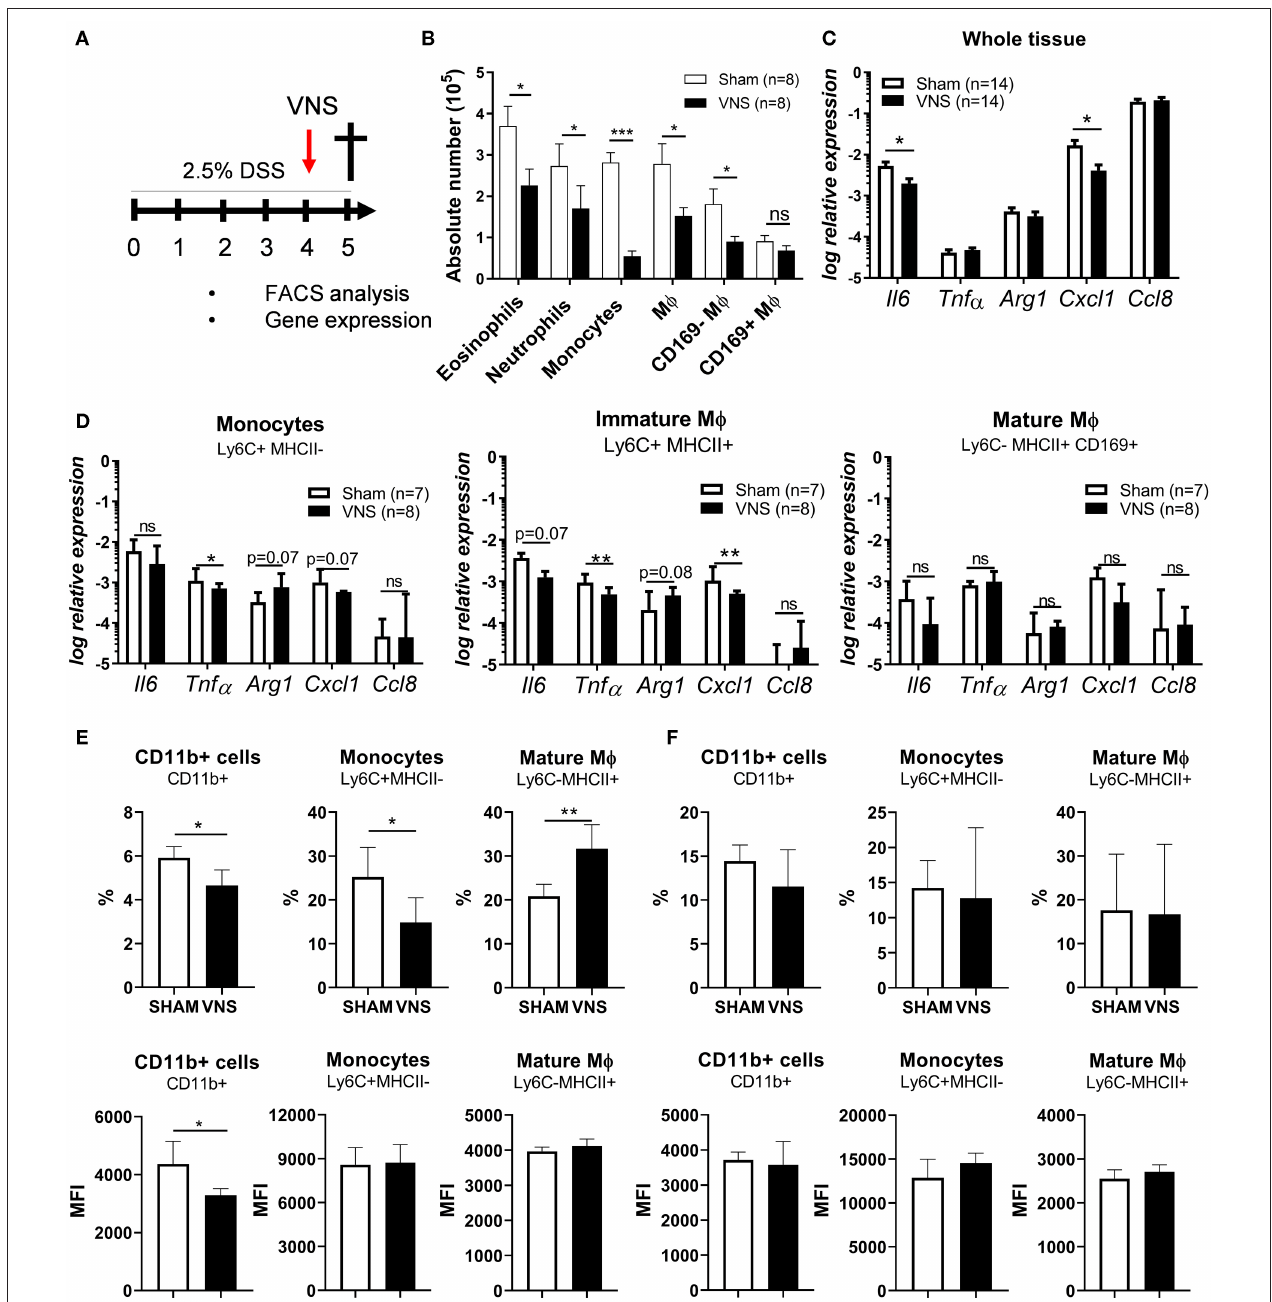
FIGURE 4 | Vagus nerve stimulation affects monocyte recruitment and dampens cytokine production by immature macrophages (M φ ) during the acute phase of colitis. (A) Wild type mice were stimulated at day 4 and exposed to 2.5% DSS in the drinking water for 5 days, colitis severity was assessed daily. Mice were sacrificed at day 5 and tissue samples were collected for different analysis. (B) Absolute numbers of eosinophils (SiglecF + CD11b + ), neutrophils (Ly6G + CD11b + ), monocytes (Ly6C + MHCII − ) and mature macrophages (M ϕ ; Ly6C − MHCII + , MCHII + ) CD169 + or CD169 − M ϕ among CD11b + cells from colon of sham- and VNS-treated mice 1 day post VNS. Data are expressed as mean ± SEM as determined by the unpaired t -test from two independent experiments. ns, not significant; * p < 0.05, ** p < 0.01, *** p < 0.001; ( n = 8 mice per group). (C,D) Pro-inflammatory cytokine and chemokine expression was quantified in whole tissue (C) ; sorted colonic monocytes, immature M ϕ and mature CD169 + M ϕ (D) isolated from sham and VNS-treated mice at day 5. Data are expressed as median ± interquartile range as determined by the Mann-Whitney test from two independent experiments. * p < 0.05, ** p < 0.01; ns, not significant; ( n = 7–14 mice per group). Data representative of two independent experiments. (E,F) The percentage and MFI of splenic (E) and blood (F) CD11b + cells, monocytes (Ly6C + MHCII − ) and mature M ϕ (M ϕ ; Ly6C − MHCII + , MCHII + ) from sham and VNS-treated mice at day 5. Data are expressed as mean ± SEM as determined by unpaired t -test. * p < 0.05, ** p < 0.01 (sham-operated mice n = 5; VNS-treated mice n =